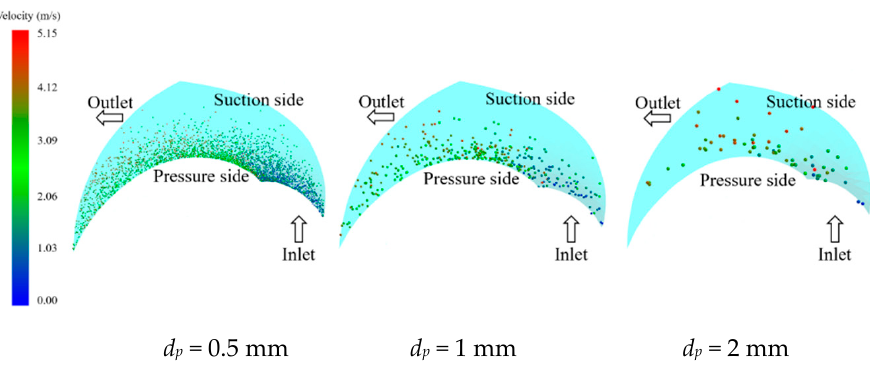
Figure 13. Distributions of particles of different sizes in one flow passage of the pump impeller.